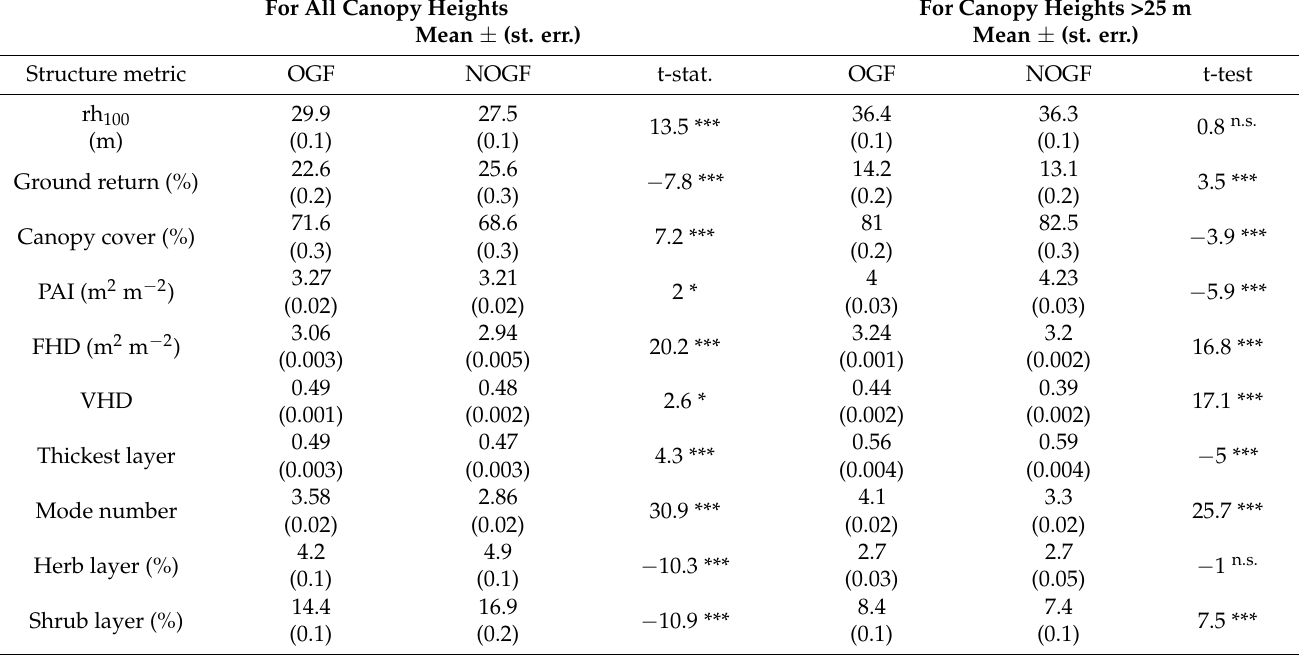
Table 3. Structural variables for old-growth forest (OGF) and non-OGF (NOGF) broadleaf stands for all canopy height values and for canopy height values over 25 m. The t-stat column shows t-value, as well as significance in superscript: n.s. is not significant, while * and *** indicates significance at 0.05 and 0.001 level respectively. St. err. Stands for standard error of the mean. For All Canopy Heights